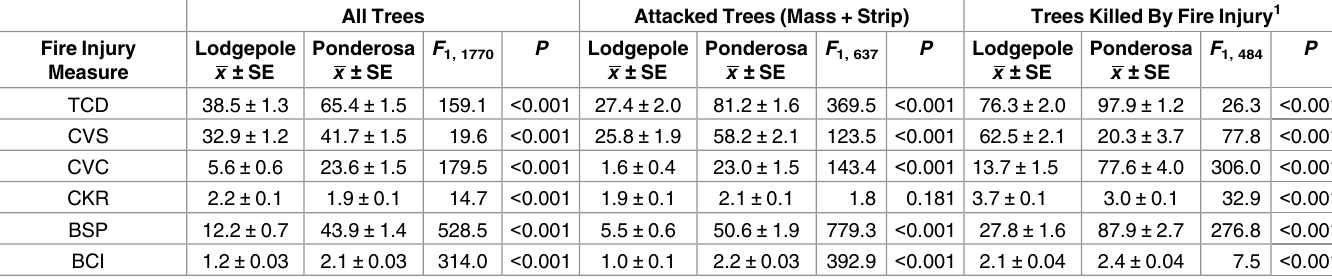
Table 2. Comparison of fire injury levels between lodgepole and ponderosa pines using one-way